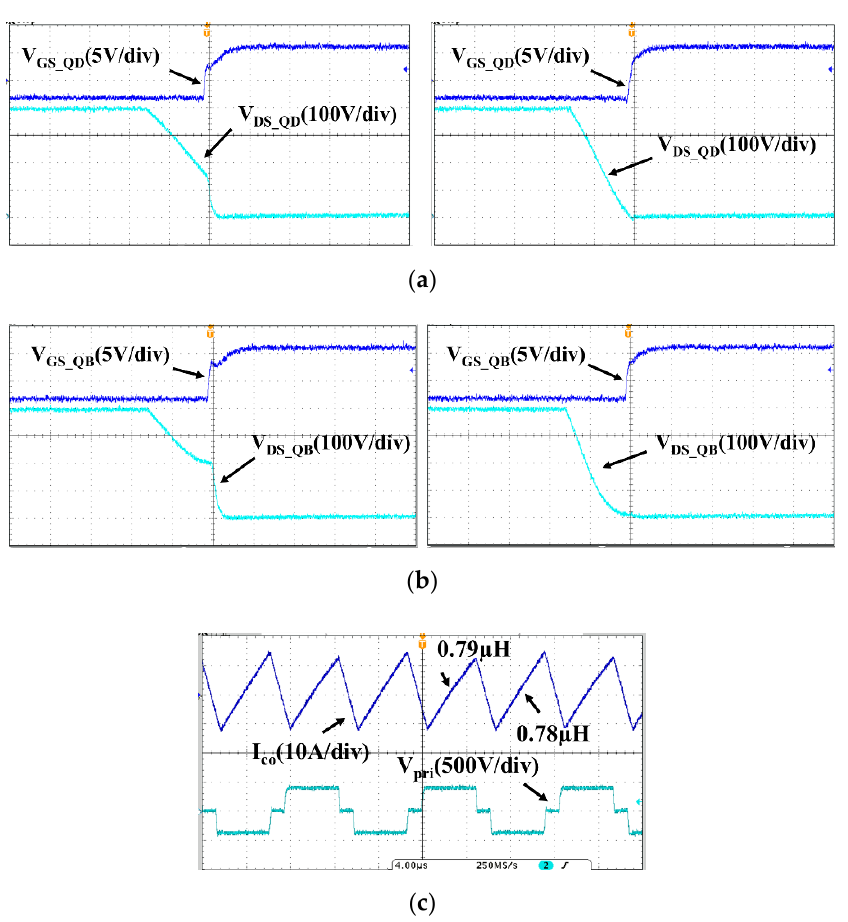
Figure 17. Measured waveforms: ( a ) Turn on transient of low side switch of leading leg at 30 and 45 A output load. ( b ) Turn on transient of low side switch of lagging leg at 45 and 80 A output load ( c ) output capacitor current ripple at full output load.